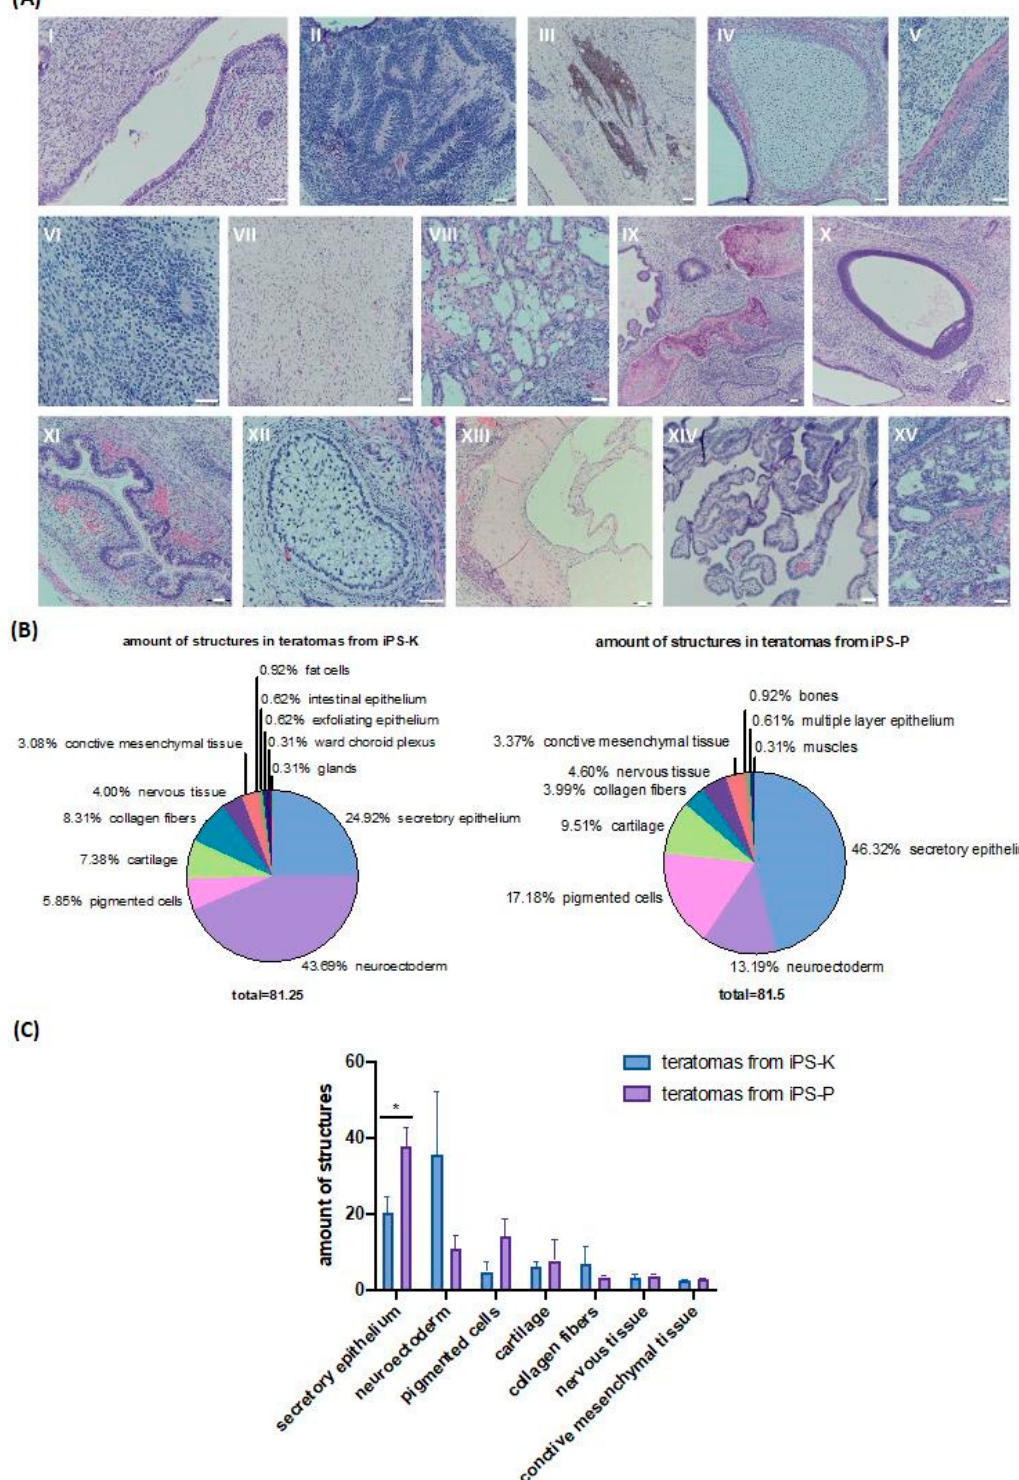
Figure 5. Formation of teratomas from iPS cells in vivo . ( A ) Representative image of structures which were found in the generated teratomas after subcutaneous implantation of iPS cells to immunodeficient NOD-SCID mice: ( AI ) secretory epithelium, ( AII ) neuroectoderm, ( AIII ) pigmented cells, ( AIV ) cartilage, ( AV ) collagen fibers, ( AVI ) nervous tissue, ( AVII ) connective mesenchymal tissue, ( AVIII ) fat cells, ( AIX ) bones, ( AX ) multiple layer epithelium, ( AXI ) intestinal epithelium,